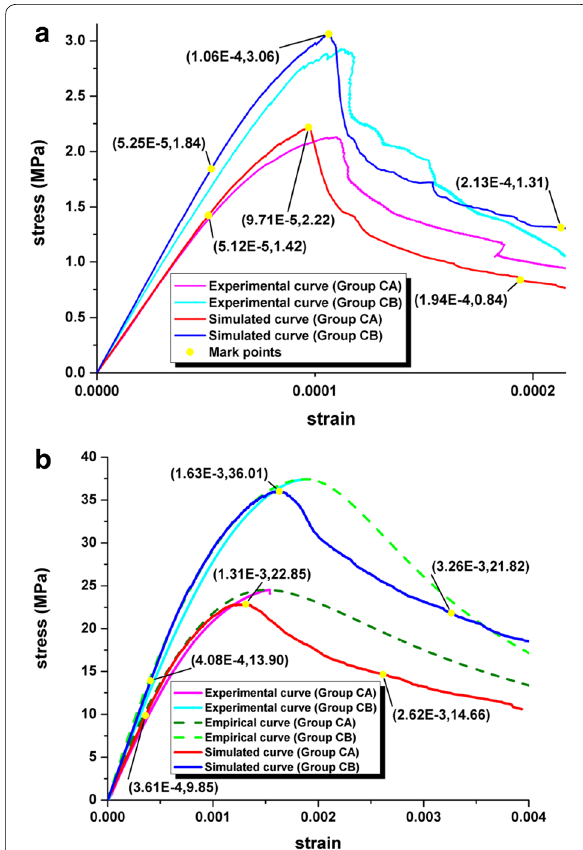
Fig. 13 Stress–strain responses under mutiple loading conditions. a Stress–strain responses under tension, b stress–strain responses under